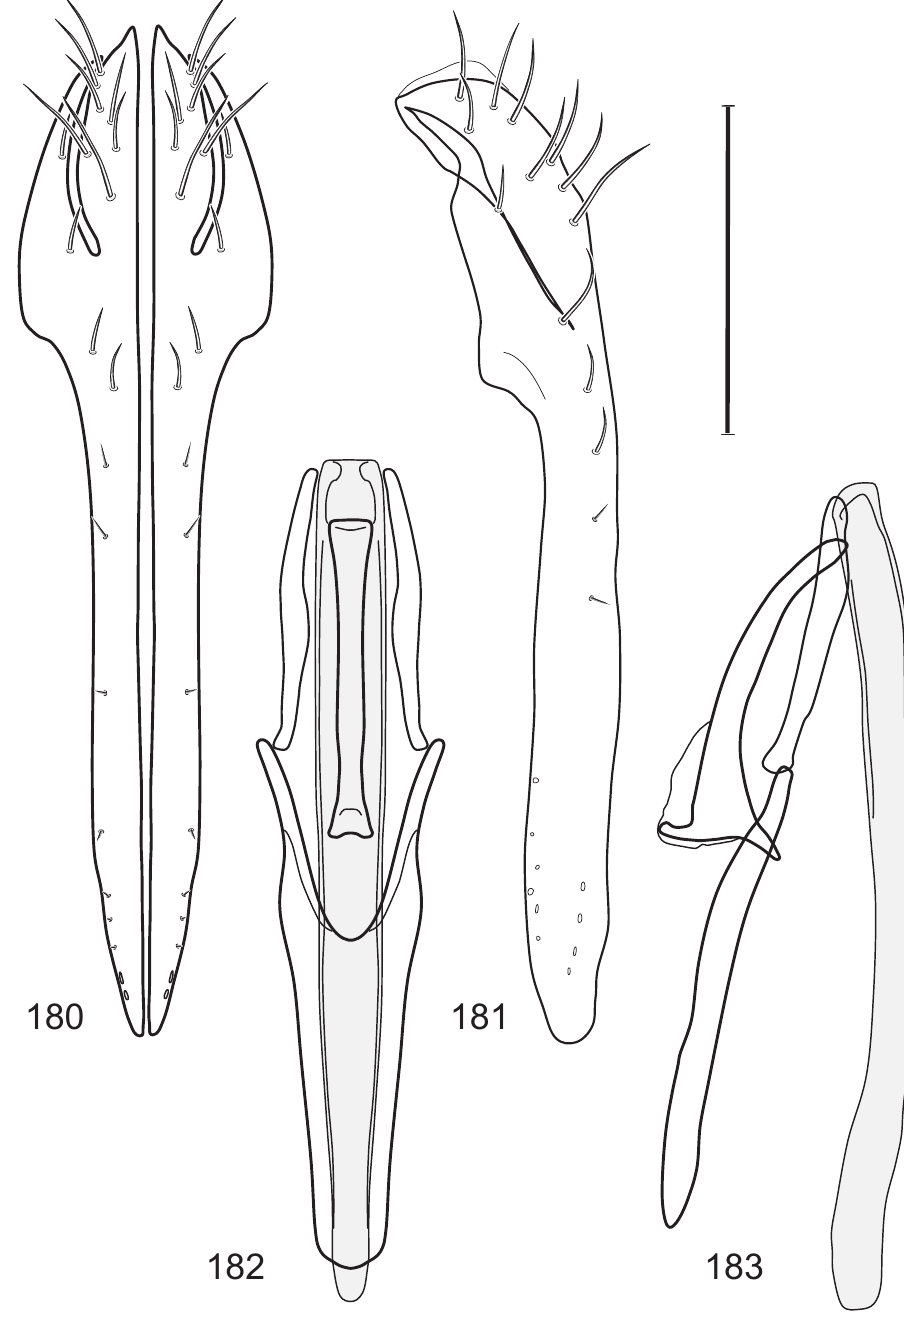
Figures 180–183. Hydrochasma lineatum sp. n. (Trinidad. St. George: Filette) 180 epandrium and cerci, posterior view 181 same, lateral view 182 internal structures of male terminalia (aedeagus [shaded], phallapodeme, gonite, hypandrium), ventral view 183 same, lateral view. Scale bar = 0.1